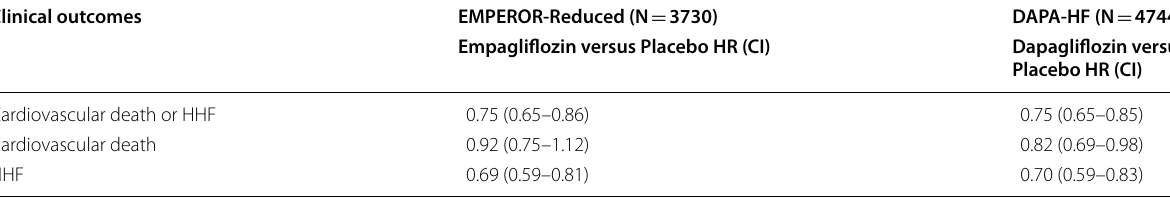
HHF hospitalisation for heart failure, HR Hazard ratio, CI confidence interval